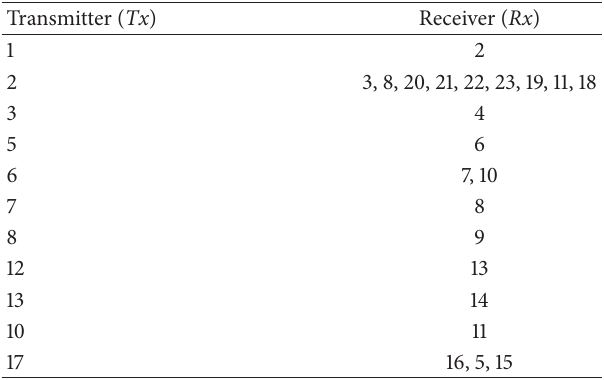
Table 1: Measurement scenario for channel